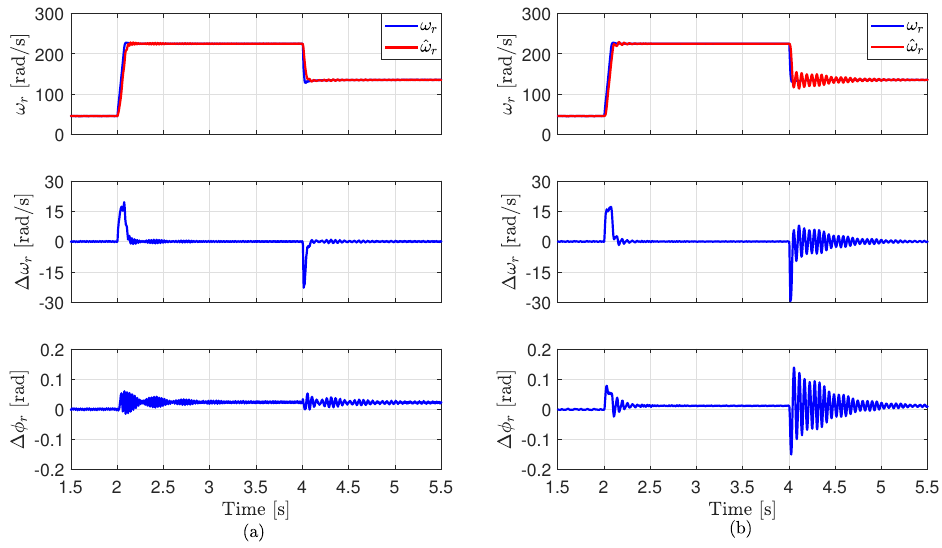
Figure 6. Experimental results at step changes in the mechanical speed of the rotor ω r of the SMPMSG: ( a ) MRAS-FS and ( b ) conventional MRAS.